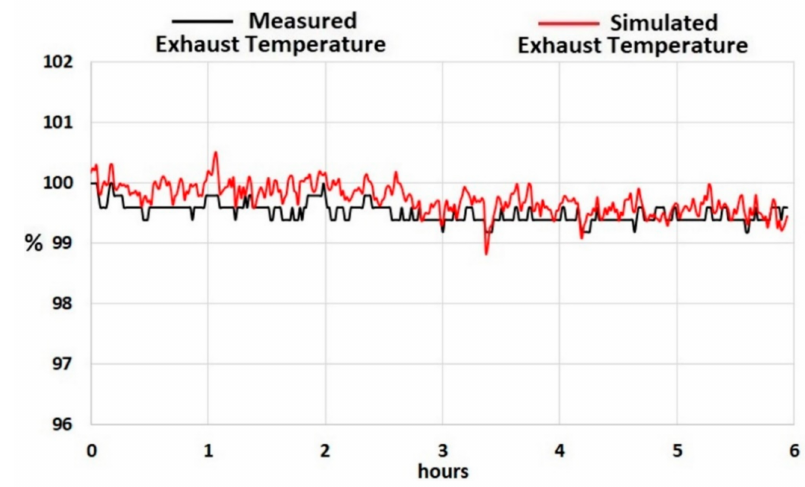
Figure 36. Measured and simulated power turbine exhaust temperatures at low IGV offset. (2) High IGV Offset